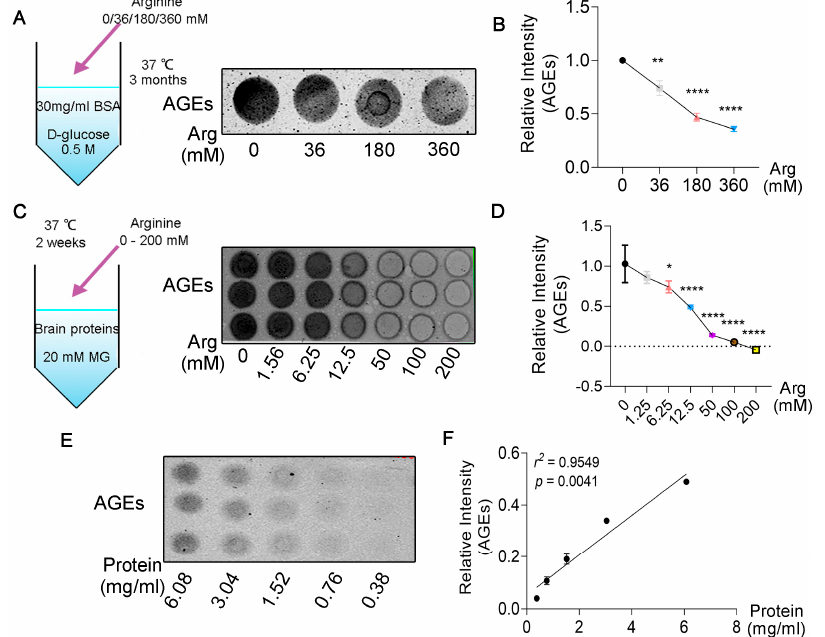
Figure 2. Arginine decreases the glycation of proteins in a dose − dependent manner. ( A , B ) Bovine serum albumin (BSA, 30 mg/mL) and D − glucose (0.5 M) were incubated with L − arginine (0, 36, 180, 360 mM) at 37 °C for 3 months. Dot blot was used to measure the level of glycation with antibody against AGEs. ( C , D ) Mice brain proteins (13.5 mg/mL), methylglyoxal (MG, 250 mM) were reacted with L − arginine (0, 1.56, 6.25, 12.5, 50, 100, 200 mM) at 37 °C for a fortnight. Dot blot was performed. ( E , F ) Sequentially diluted samples from ( C ) (proteins + MG + Arg (6.25 mM)) were detected through dot blot with antibody against AGEs and assessed by correlation analyses. Significant correlation ( r 2 = 0.9549, p = 0.0041). Data are exhibited as mean ± SD ( n = 3). ( B , D ) statistical analysis with one − way ANOVA with a post hoc Turkey’s test. * p < 0.005, ** p < 0.001, **** p < 0.0001 vs. 0 − Arg group.